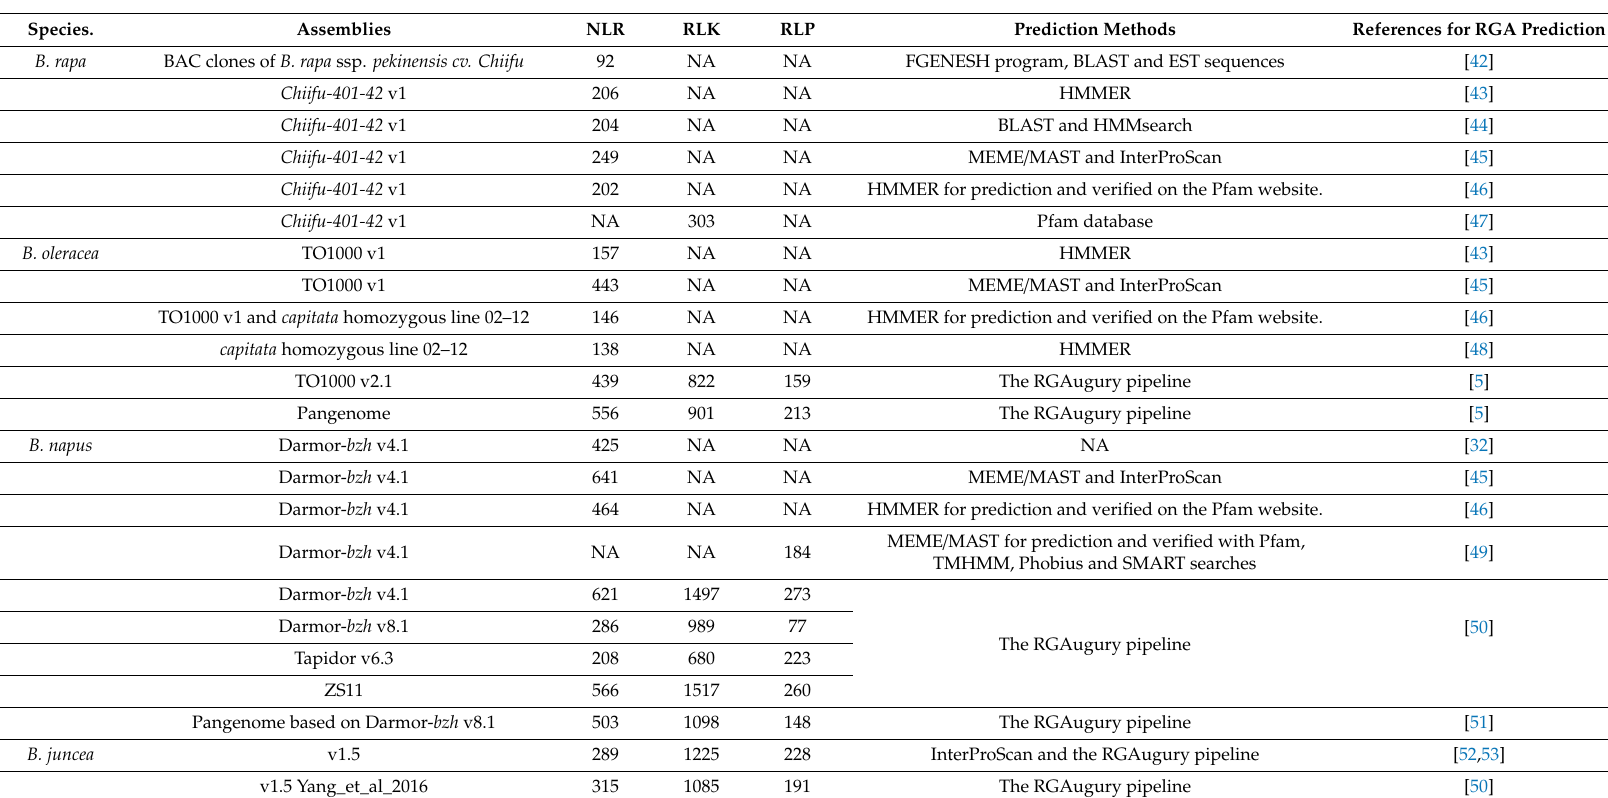
Table 1. Summary of the Genome-wide Prediction of nucleotide-binding-site leucine-rich repeat (NLR), receptor-like kinase (RLKs) and receptor-like proteins (RLPs) in Brassica Genome